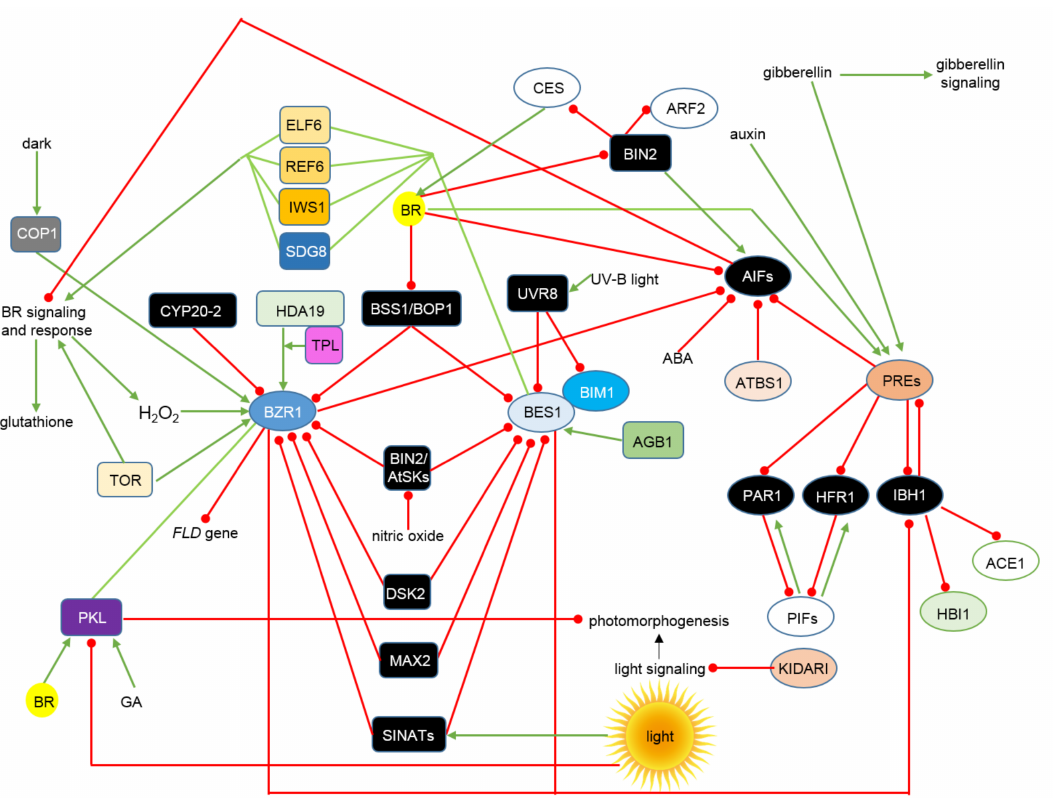
Figure 2. The complicated mechanism, which coordinately regulates the BR-dependent gene expression, with the BZR1 and BES1 transcription factors as hubs of the regulatory network. Transcription factors are shown as ovals, other proteins are depicted as rectangles. Green arrows indicate stimulation, whereas red lines with the bullet points represent suppression. Detailed description is given in the